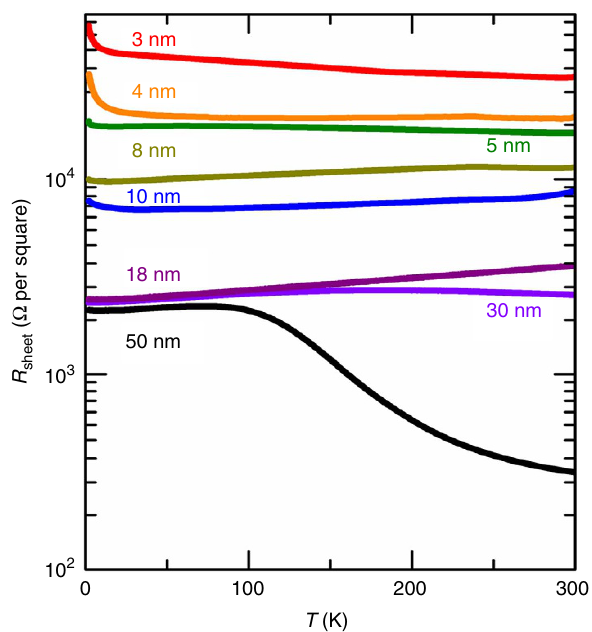
Figure 5 | Thickness dependence of electrical transport for BSTS thin films. Temperature dependence of the electrical transport for Bi 1.5 Sb 0.5 Te 1.7 Se 1.3 thin film with various film thickness grown by the van der Waals epitaxy physical vapour deposition are displayed. NATURE COMMUNICATIONS|7:13763|DOI: